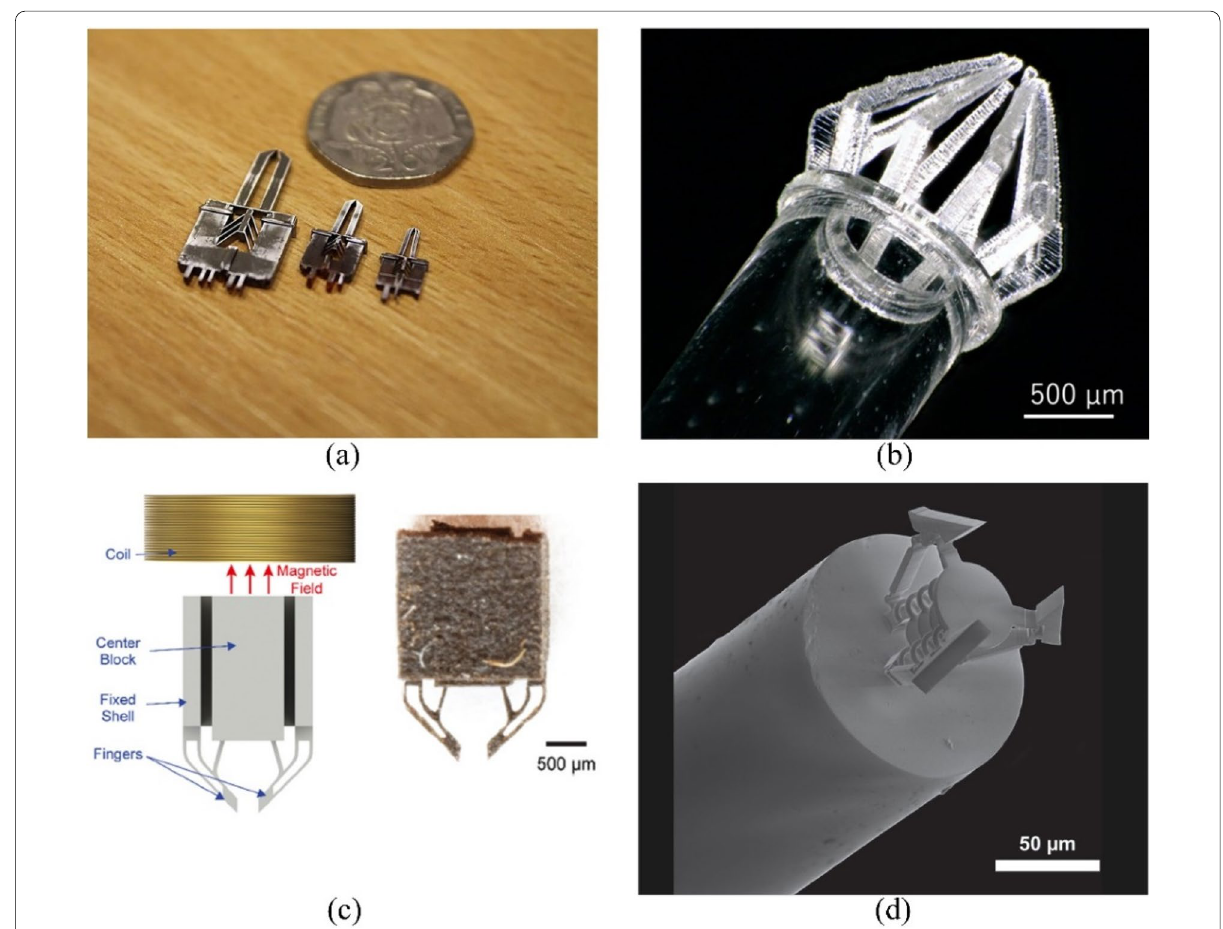
Figure 11 CMMs fabricated using 3D printing: ( a ) Microgripper by K. Alblalaihid, et al. with SLA of R11 photopolymer [106]. (©IOP. Adapted by permission of IOP. Permission to reuse must be obtained from the rightsholder.) ( b ) Micromanipulator by S. Kozaki, et al. with SLA of a mixed photo-curable polymer [107]. (©MDPI. Adapted by permission of MDPI. Permission to reuse must be obtained from the rightsholder.) ( c ) Magnetically-actuated microgripper by G. Shao using μCLIP [105]. (©Elsevier. Adapted by permission of Elsevier. Permission to reuse must be obtained from the rightsholder.) ( d ) Monolithic force-sensitive 3D microgripper by M. Power with 2PP [110]. (©Wiley. Adapted by permission of Wiley. Permission to reuse must be obtained from the